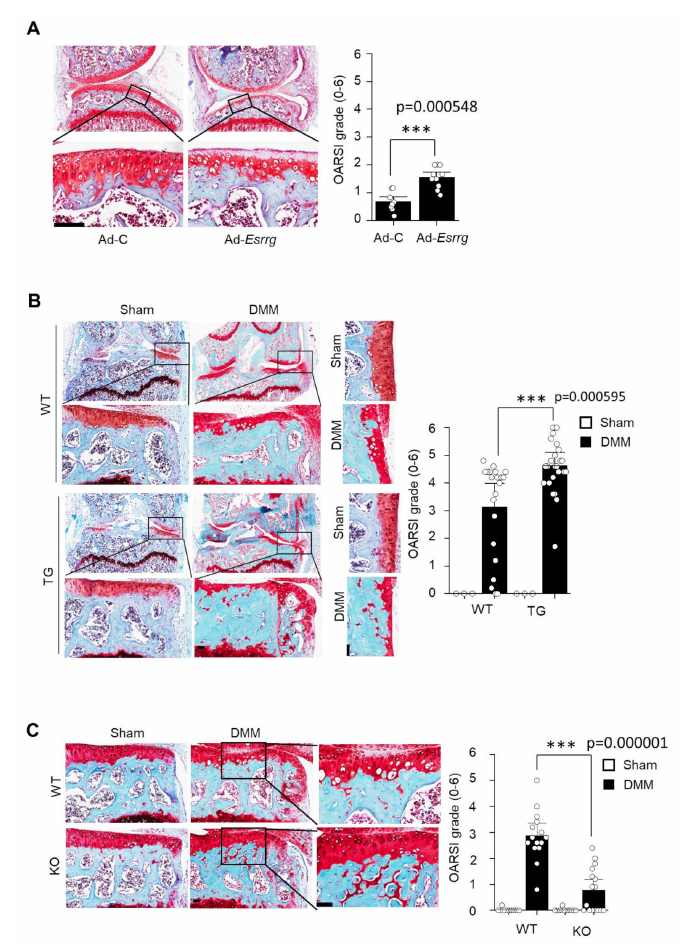
Figure 3. ERR γ regulates OA pathogenesis ( A ) ERR γ overexpression causes cartilage